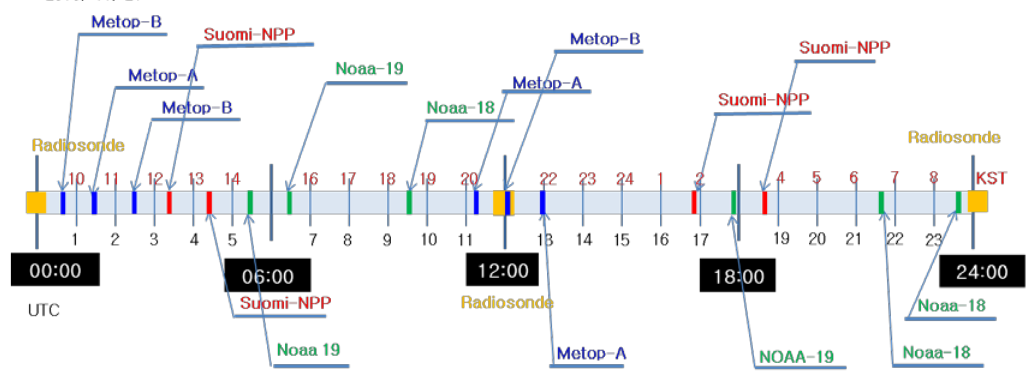
Figure 1. Low Earth orbit (LEO) overpass time above the Korean peninsula. Table 1. Overpass time above the Korean peninsula, horizontal and vertical resolutions for each satellite on 11 November 2016.